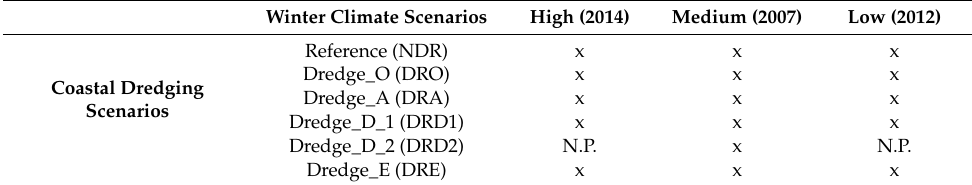
Table 2. Simulations performed to dredging scenarios during January, February, and March of representative winter wave climate: high-energy wave (2014), medium-energy wave (2007), and low-energy wave (2012). Note: N.P. not